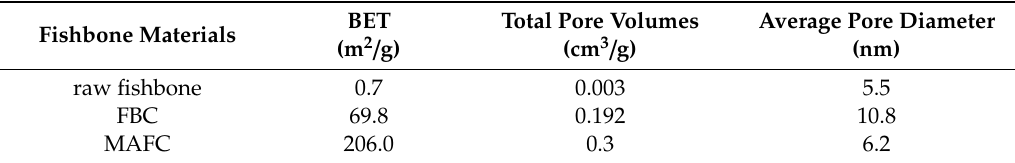
Table 1. Specific surface area parameters of fishbone charcoal.